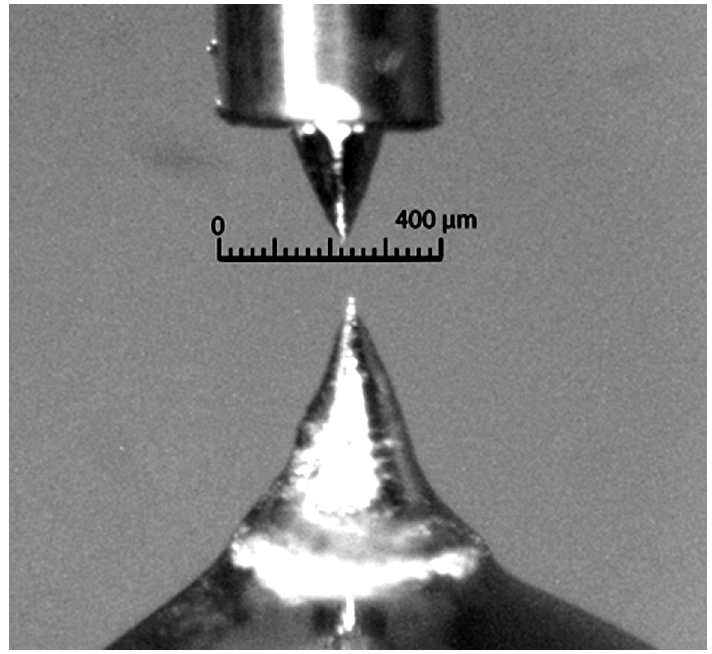
Figure 2. Photo of a formed conical eutectic liquid electrode.